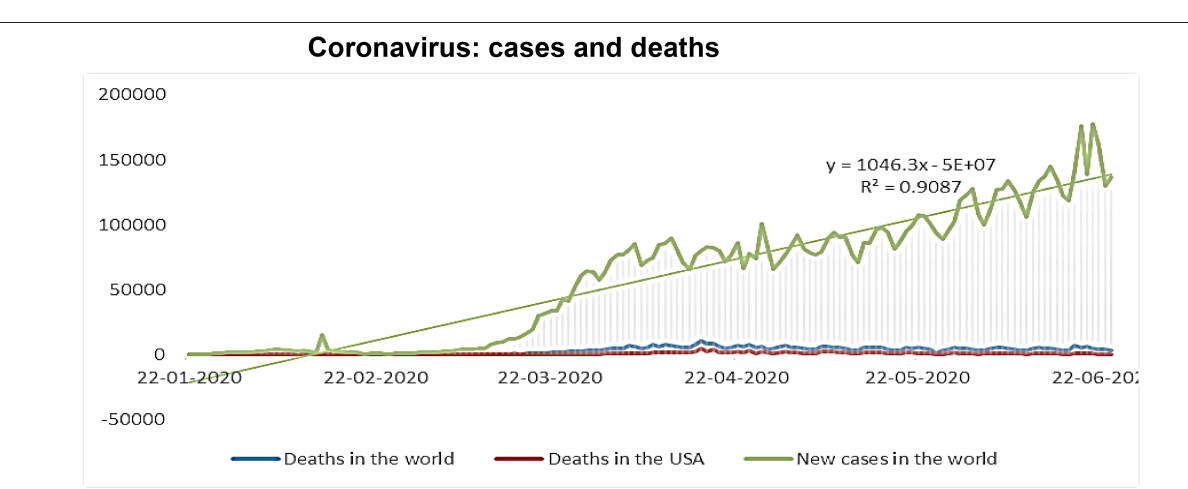
FIGURE 3 | Coronavirus: cases and deaths. Source: Authors’ calculations, based on who.int